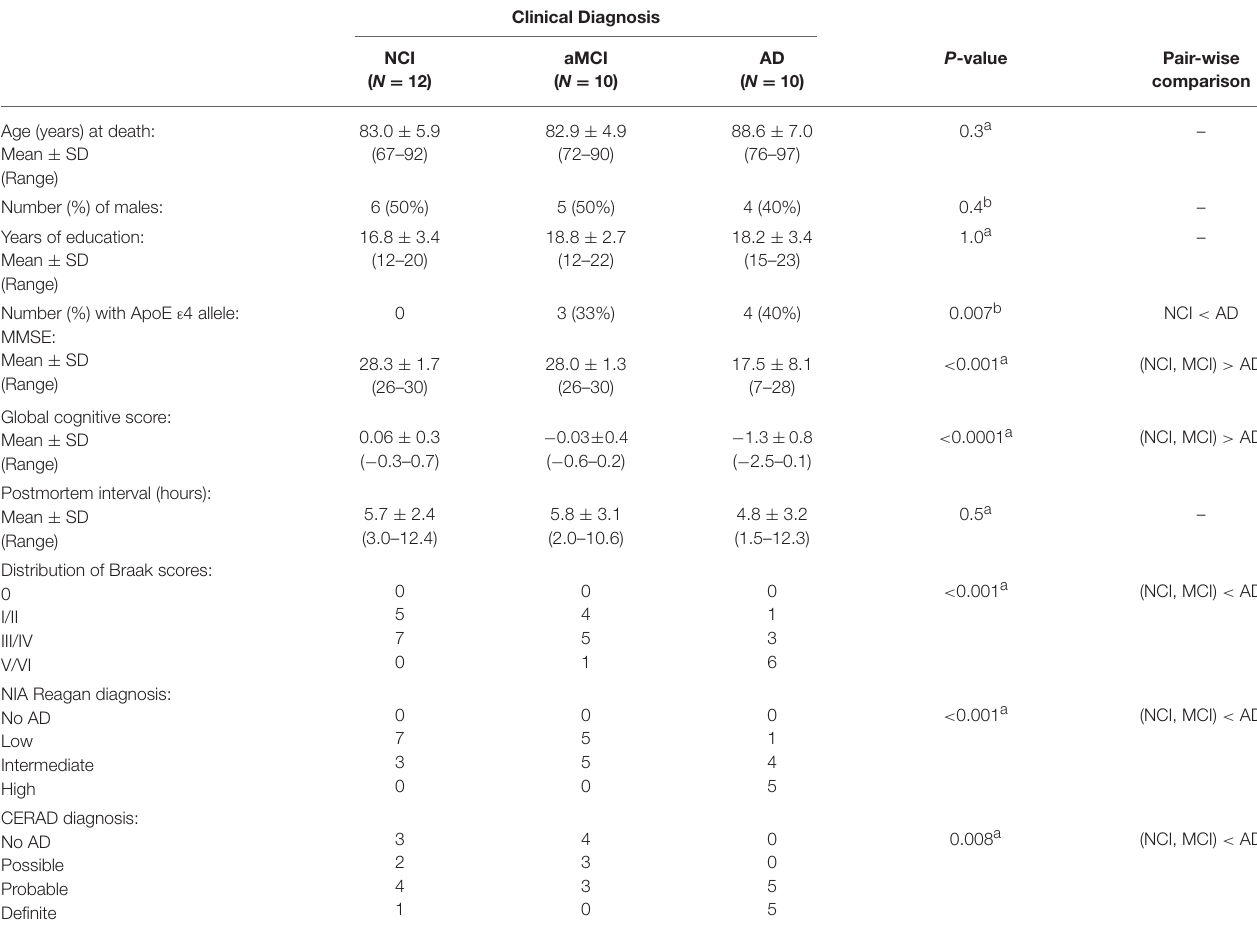
TABLE 1 | Clinical, demographic, and neuropathological characteristics by diagnosis category.